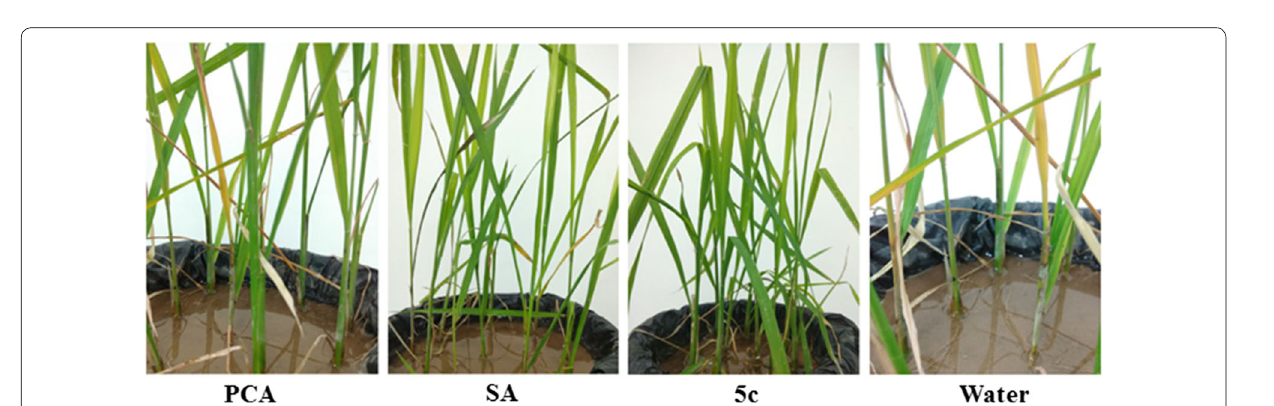
Fig. 6 Protection of rice plants against Rhizoctonia solani by a foliar spray with 200 μmol/L PCA ( PCA ), 200 μmol/L SA ( SA ), 200 μmol/L of conjugate 5c ( 5c ) and distilled water (water) 14 days after inoculation with Rhizoctonia solani conidial suspension (10 5 spore/mL)